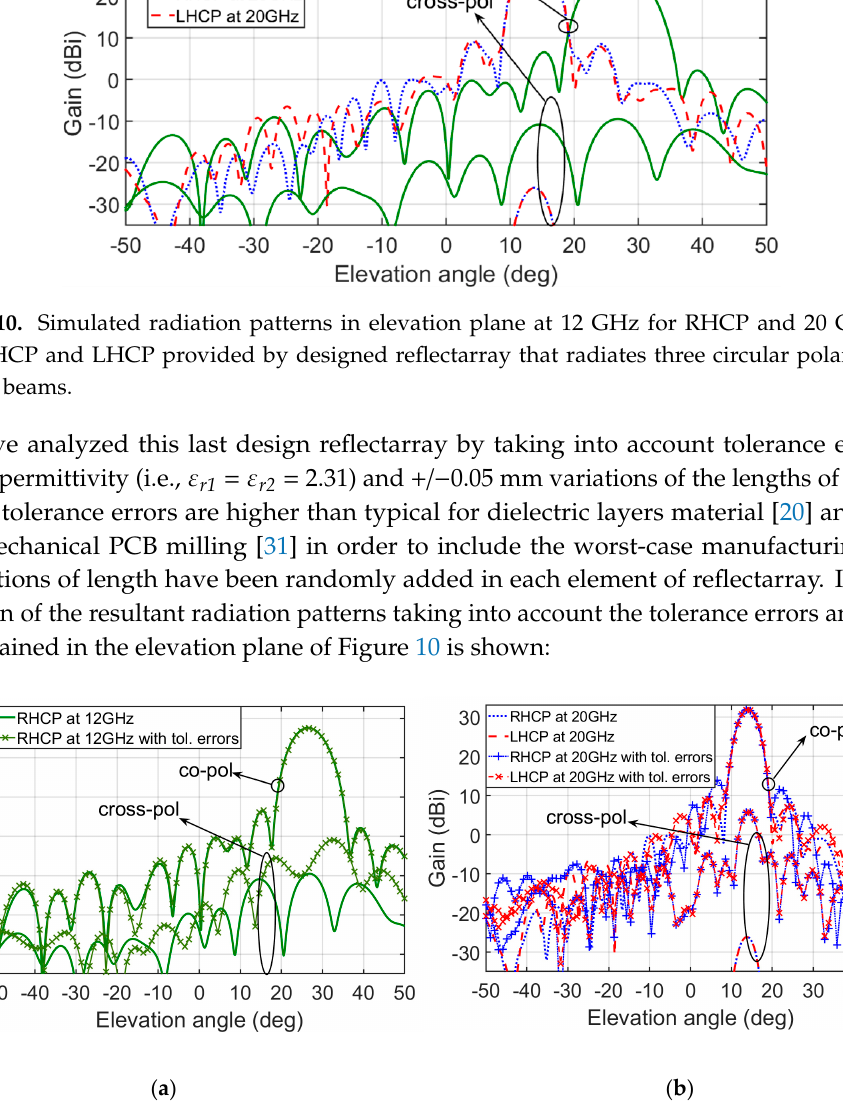
Figure 9. ( a ) Maximum of simulated gain versus frequency for frequencies closer 12 GHz. ( b ) Maximum gains versus frequency for frequencies closer 20 GHz.